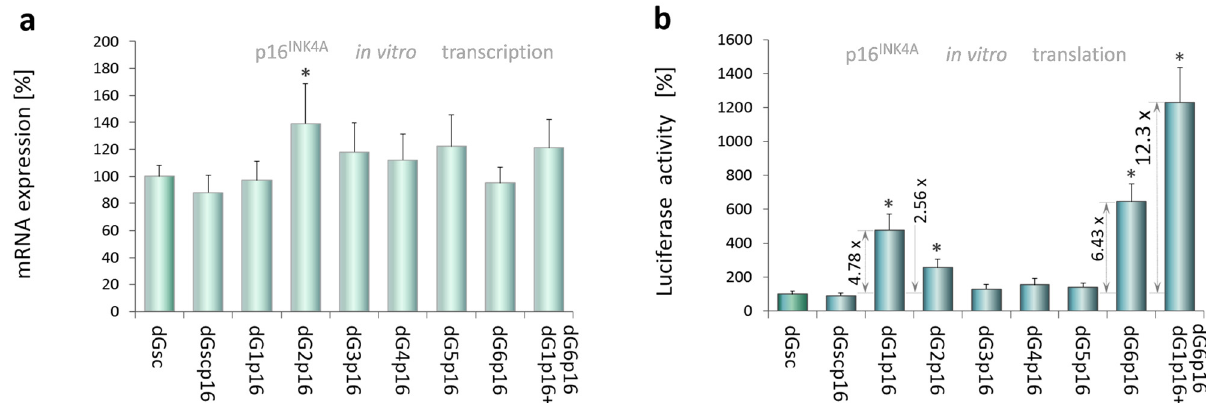
Fig 5. dGoligo-mediated upregulation of CDKN2A expression. PCR-amplified linear luciferase expression construct containing 5 ’ UTR of p16 INK4a ( CDKN2A ) was generated (S1 Appendix) and used as a template in coupled transcription-translation assay that was performed as described in experiments with TR β 1 5'UTRs. ( a ) Luciferase mRNA levels after 6-hour in vitro reaction of the linear construct with a DNA- based dGoligos dG1p16 — dG6p16, dG1p16+dG6p16 or dGscp16 (S3 Table) targeting the p16 INK4a 5'UTR. ( b ) Luciferase activity as a measure of dG-mediated translational control. All data are shown as mean % mRNA (a) or luciferase activity (b) ± SD. Data were analyzed by ANOVA followed by Dunnett ’ s multiple comparison test. * p < 0.001 vs.